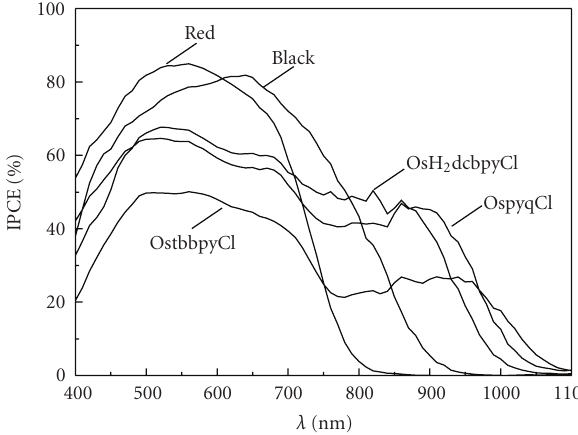
Figure 3: Photoaction spectra of Os dyes measured in sandwich type solar cells (nanocrystalline TiO 2 films, electrolyte made of 2M LiI+0.1M I 2 in γ -butyrolactone). OsH 2 dcpyCl = [Os(H 3 tcterpy)(H 2 dcbpy)(Cl)] + ;OstbbpyCl = [Os(H 3 tcterpy)(tbbpy)(Cl)] + ; OspyqCl = [Os(H 3 tcterpy)(pyq)(Cl)] + . Red and black dye are N3 and Ru(H 3 Tcterpy)(NCS) −